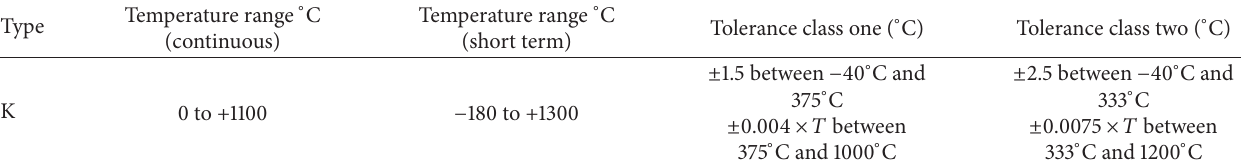
Figure 2: Internal view of an insulated plywood box and test arrangement and test instrument. Table 4: Characteristic of thermocouple Type